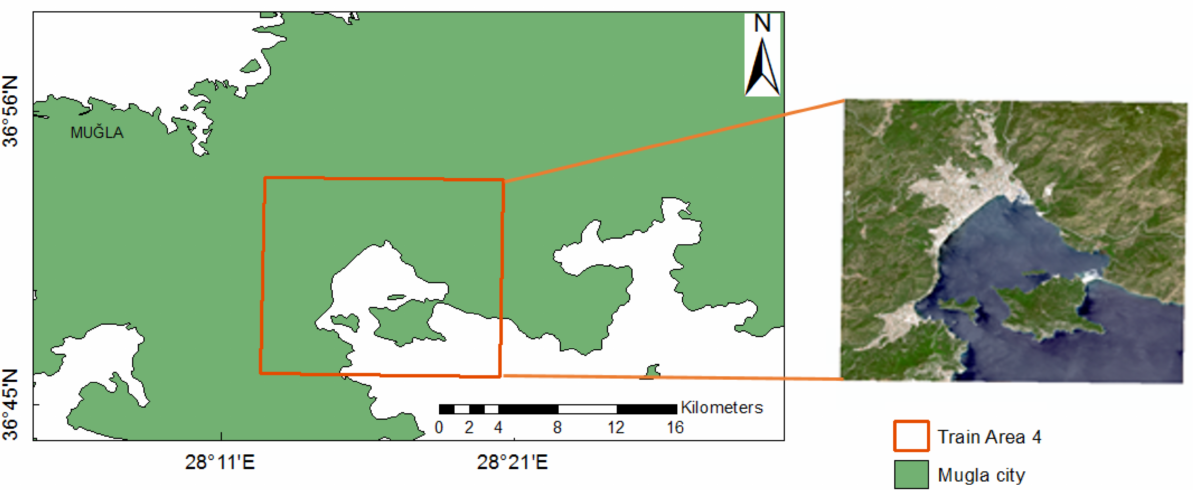
Figure 4. Subset image of Sentinel-2A for the training area 4 in Mugla city for the experiment in Mugla